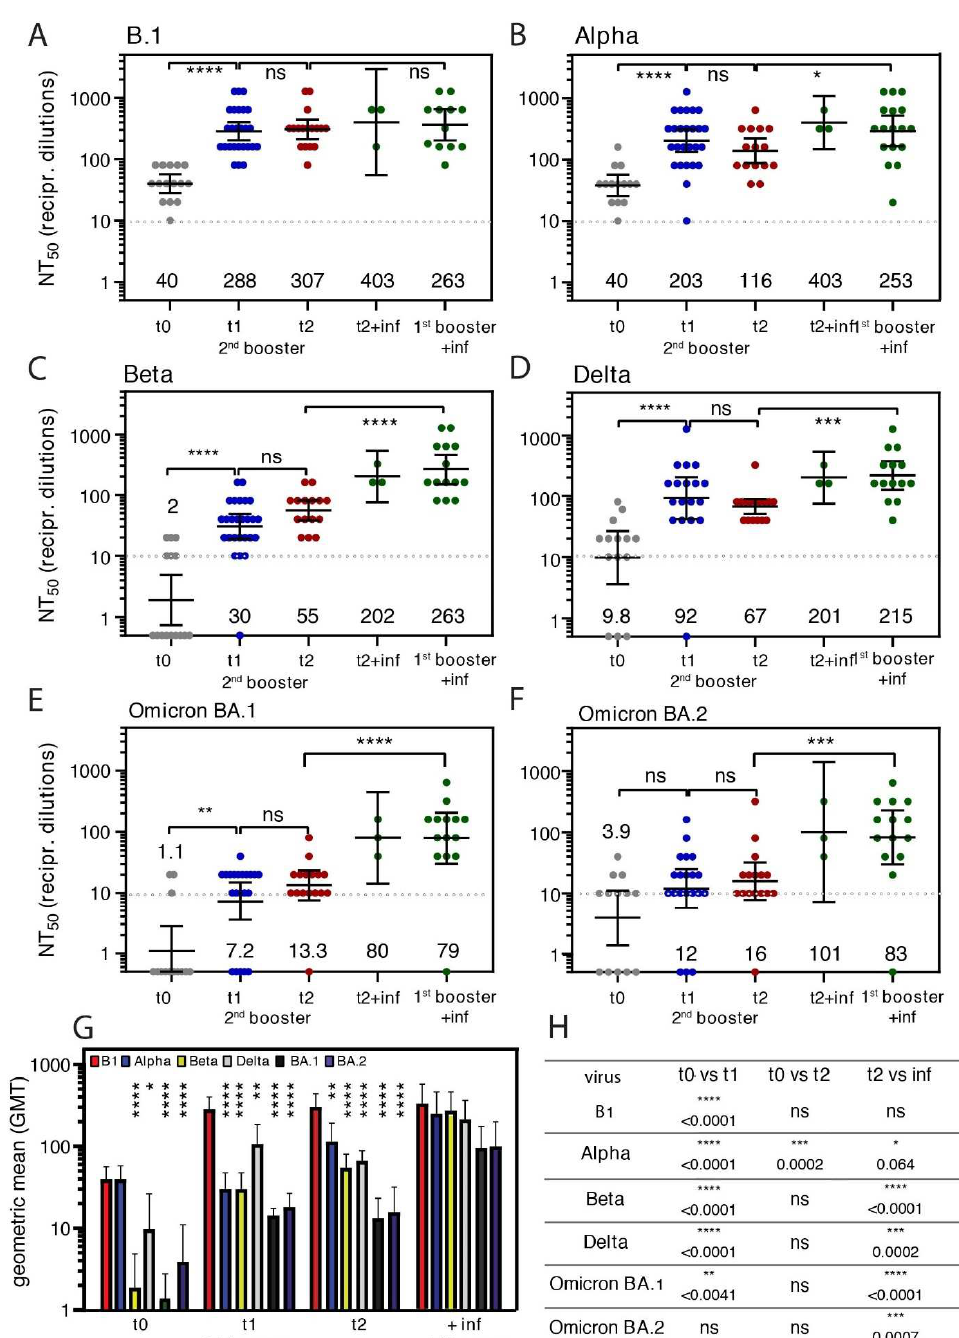
Figure 3. Characterization of neutralization titers after the second booster or infection against different VOCs. Neutralization assays were conducted using the authentic SARS-CoV-2 strains B.1 ( A ), Alpha ( B ), Beta ( C ), Delta ( D ), and Omicron BA.1 ( E ) and Omicron BA.2 ( F ) using sera from recipients after the second booster vaccinations at t0 (N = 15), t1 (N = 26) and t2 (N = 15). The analysis also included sera from individuals after breakthrough infections after the second booster (N = 3) and first booster (N = 17) (unpaired, non-parametric, Mann–Whitney, error bars = geometric mean with 95% CI). Statistics are summarized in (H). ( G ) Graph depicting the geometric means of tested groups as indicated by the color code (unpaired, non-parametric, Mann–Whitney). ( H ) Summary of the statistical analysis of A–F (unpaired, non-parametric, Mann–Whitney). Asterisks indicate significance: **** p < 0.0001; *** p < 0.001; ** p < 0.01; * p > 0.01, ns =